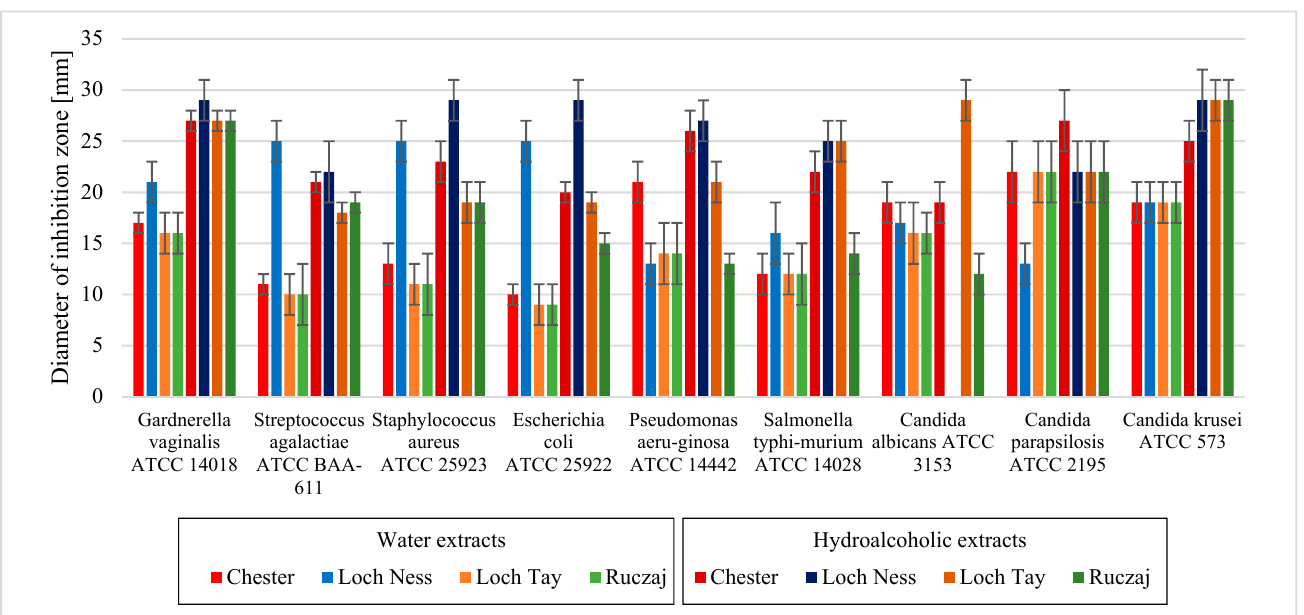
Figure 3. Microbiological activity of blackberry leaves extracts in their initial concentrations on health ‐ promoting bac ‐ teria. Error bars define the SD values.